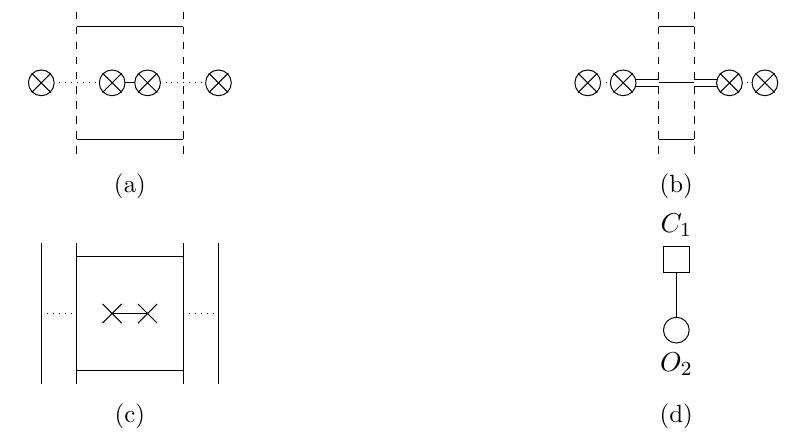
Figure 23. Transverse slice S = A 1 that can be removed via Kraft-Procesi transition. (a) Local brane con(cid:12)guration obtained from model in (cid:12)gure 17(h). (b) Phase transition to get closer to the Coulomb branch brane con(cid:12)guration . (c) Coulomb branch brane con(cid:12)guration after aligning the D3-branes in (b), performing a rotation and giving the D3-branes a generic position along the ~x direction. (d) Quiver corresponding to brane system (c).